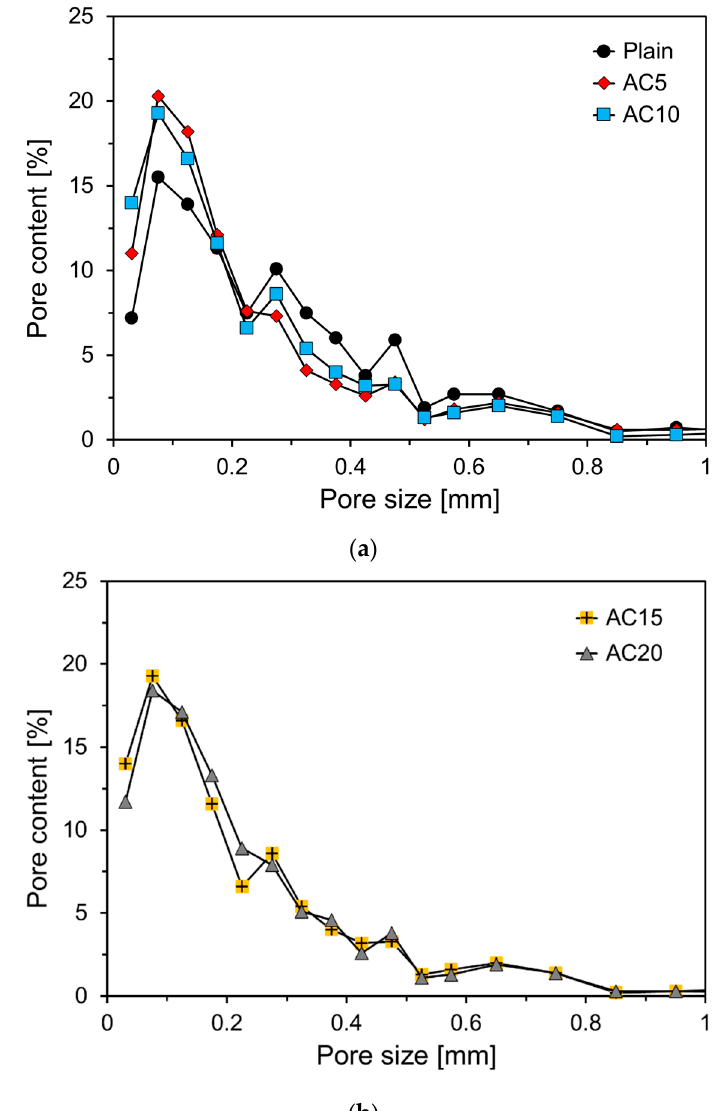
Figure 6. Pore contents of foam composite specimens. ( a ) Plain, AC5, AC10; ( b ) AC15 and AC20.